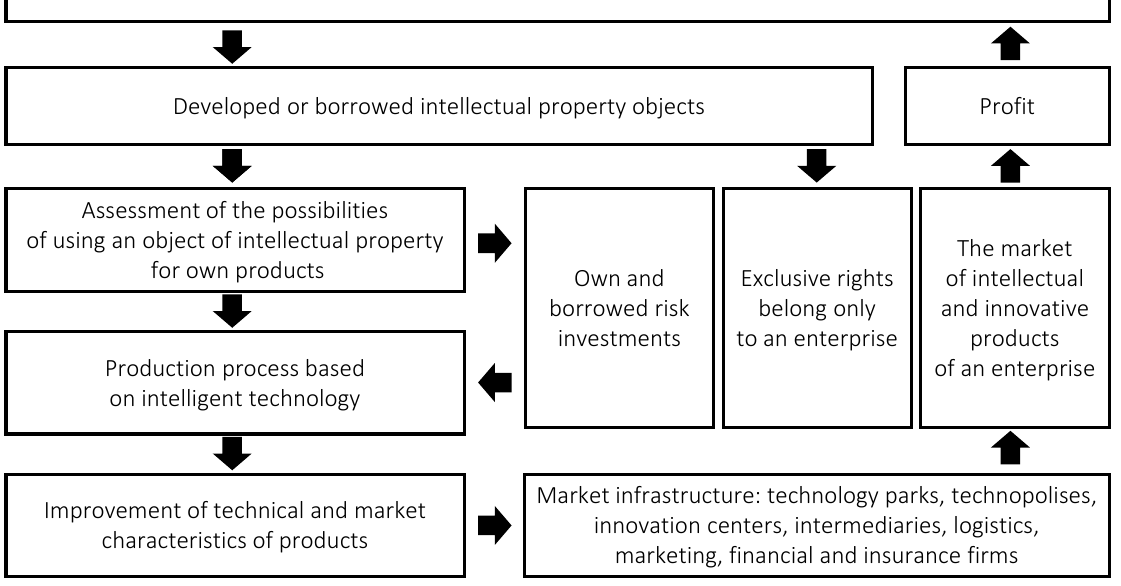
Figure 2. Vertical commercialization of intellectual property objects